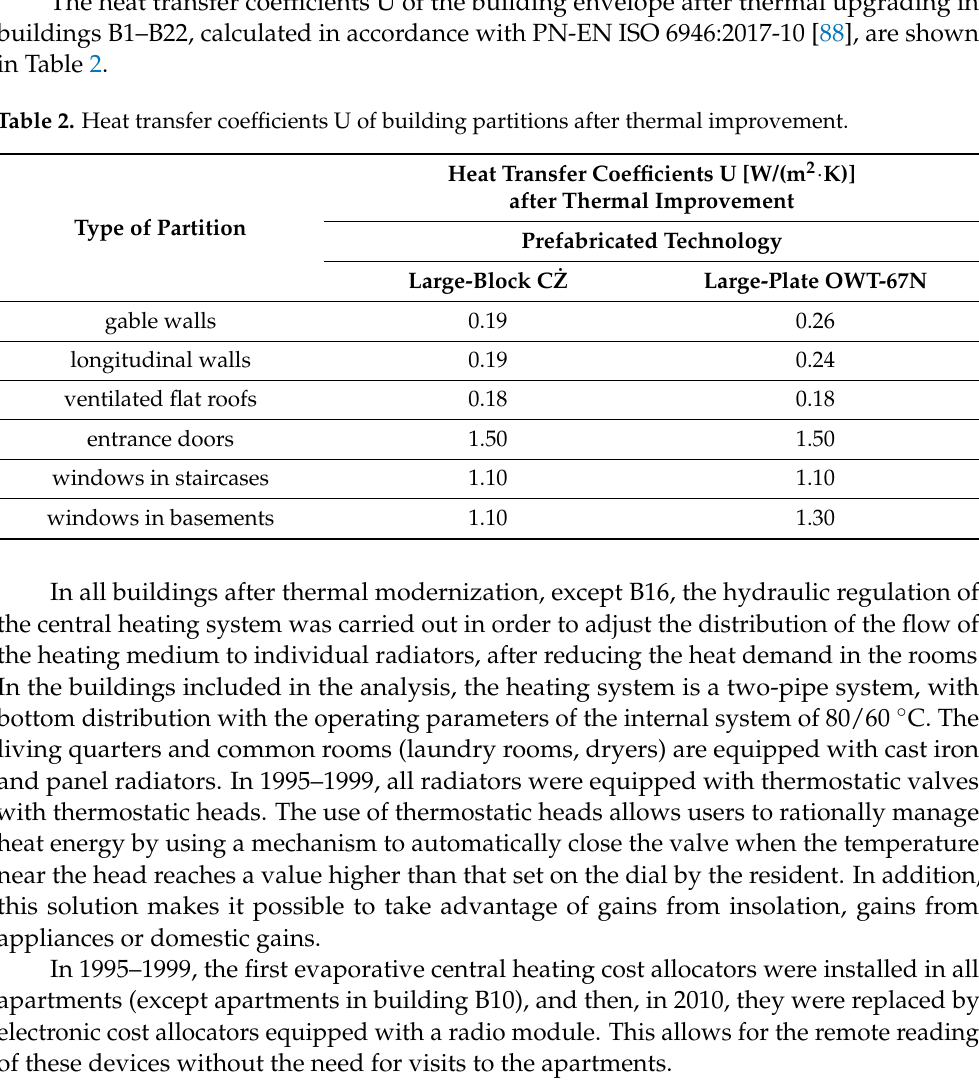
Table 2. Heat transfer coefficients U of building partitions after thermal improvement.